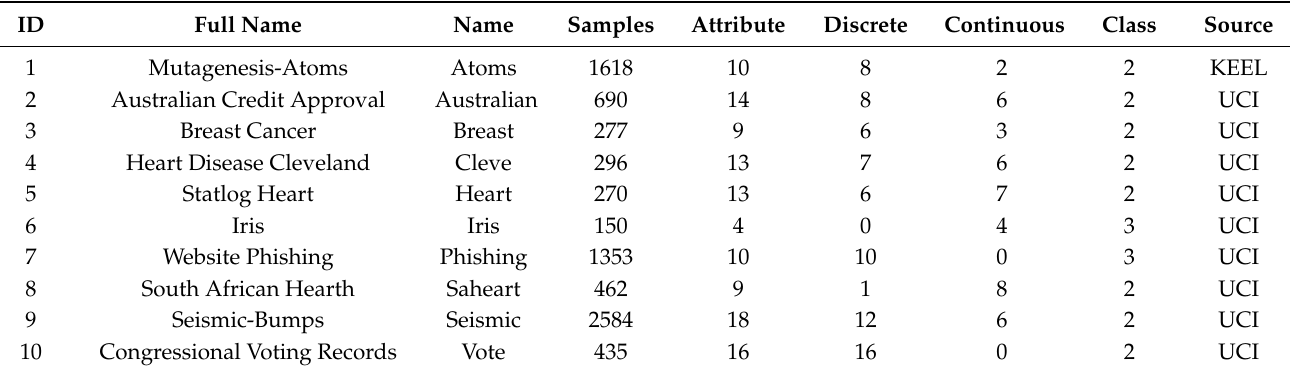
Table 4. The information of the employed